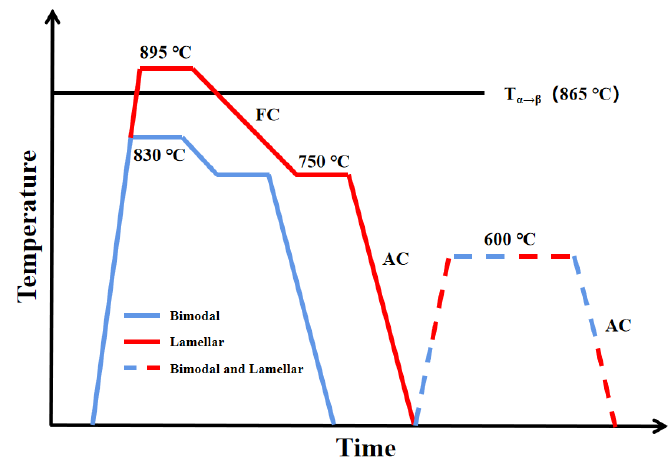
Figure 1. Heat treatment routes for bimodal and lamellar samples.